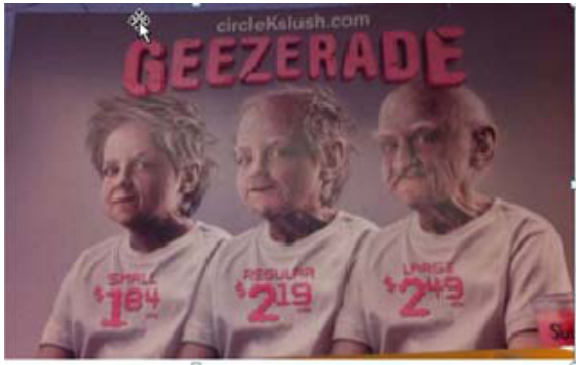
Sage Play. “It Feels Good to be Old at Heart”